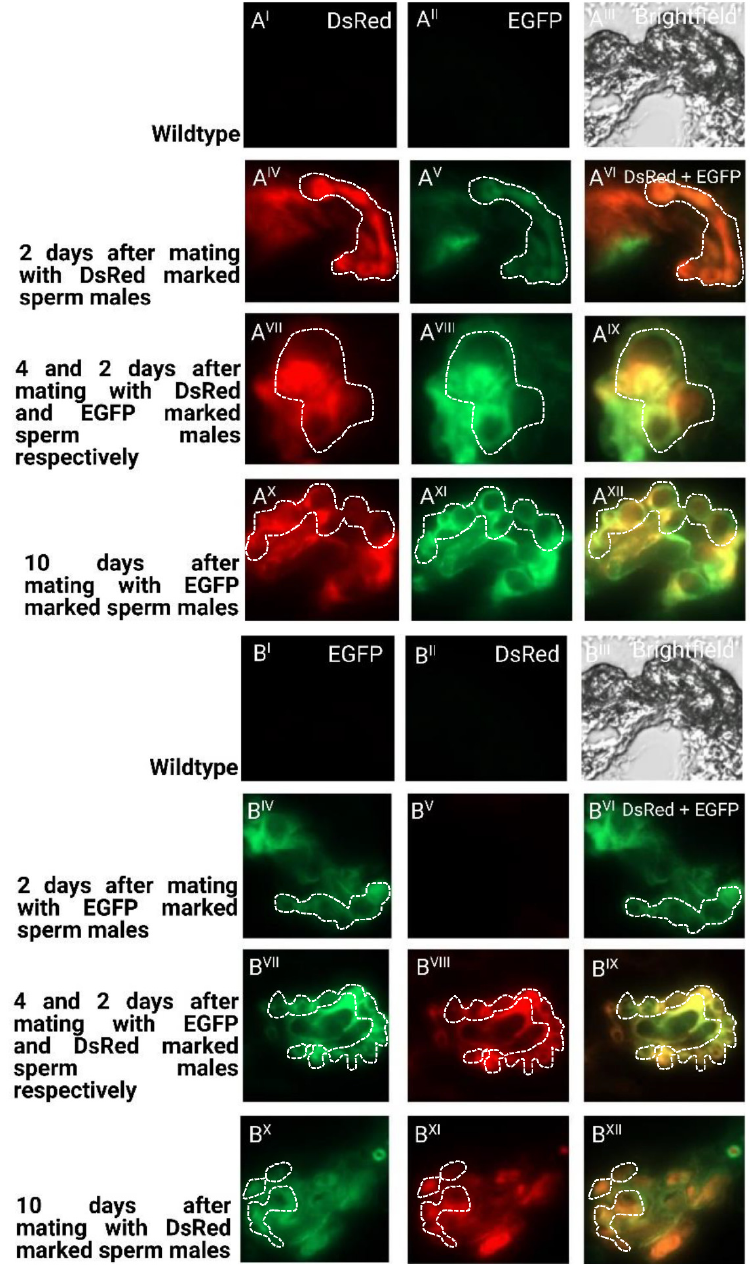
Figure 5. Cryosections of female reproductive tissue with fluorescent sperm after successive mating events: (I–III) non ‐ transgenic females mated to non ‐ transgenic males as negative control regarding autofluorescence; (IV–VI) two days after mating with first male before mating with second male;